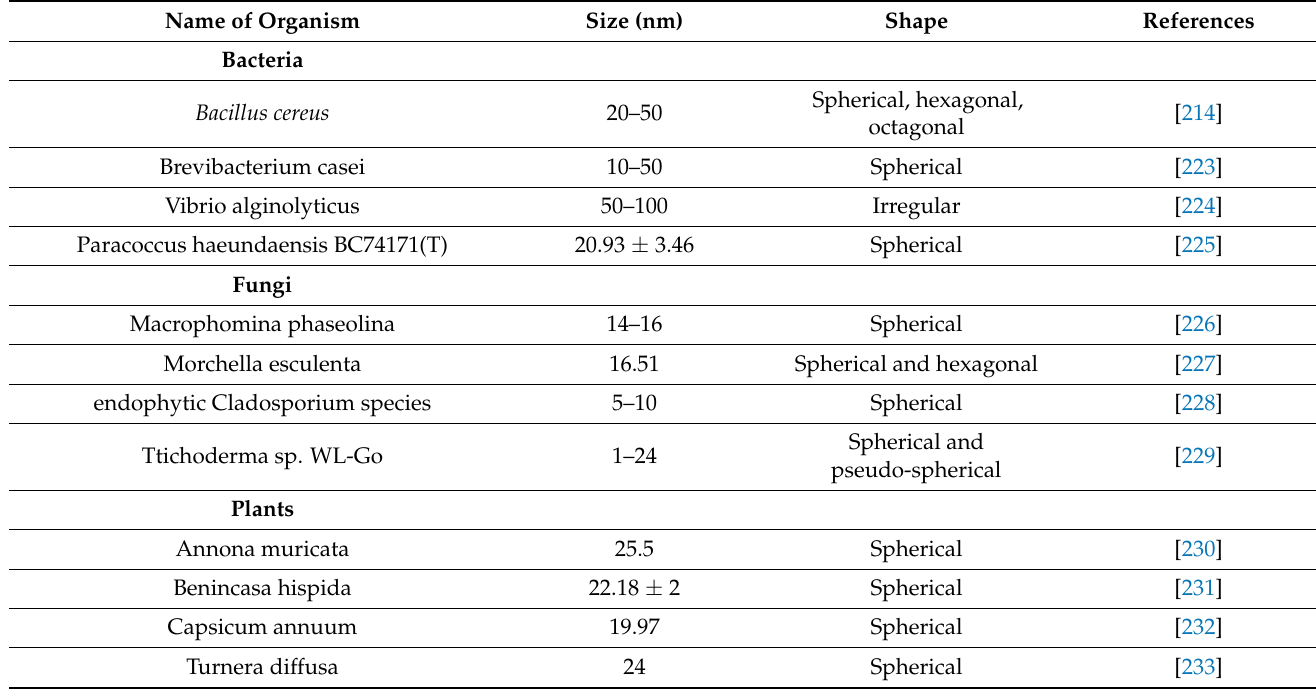
Table 7. Characteristics of gold nanoparticles synthesized from different raw